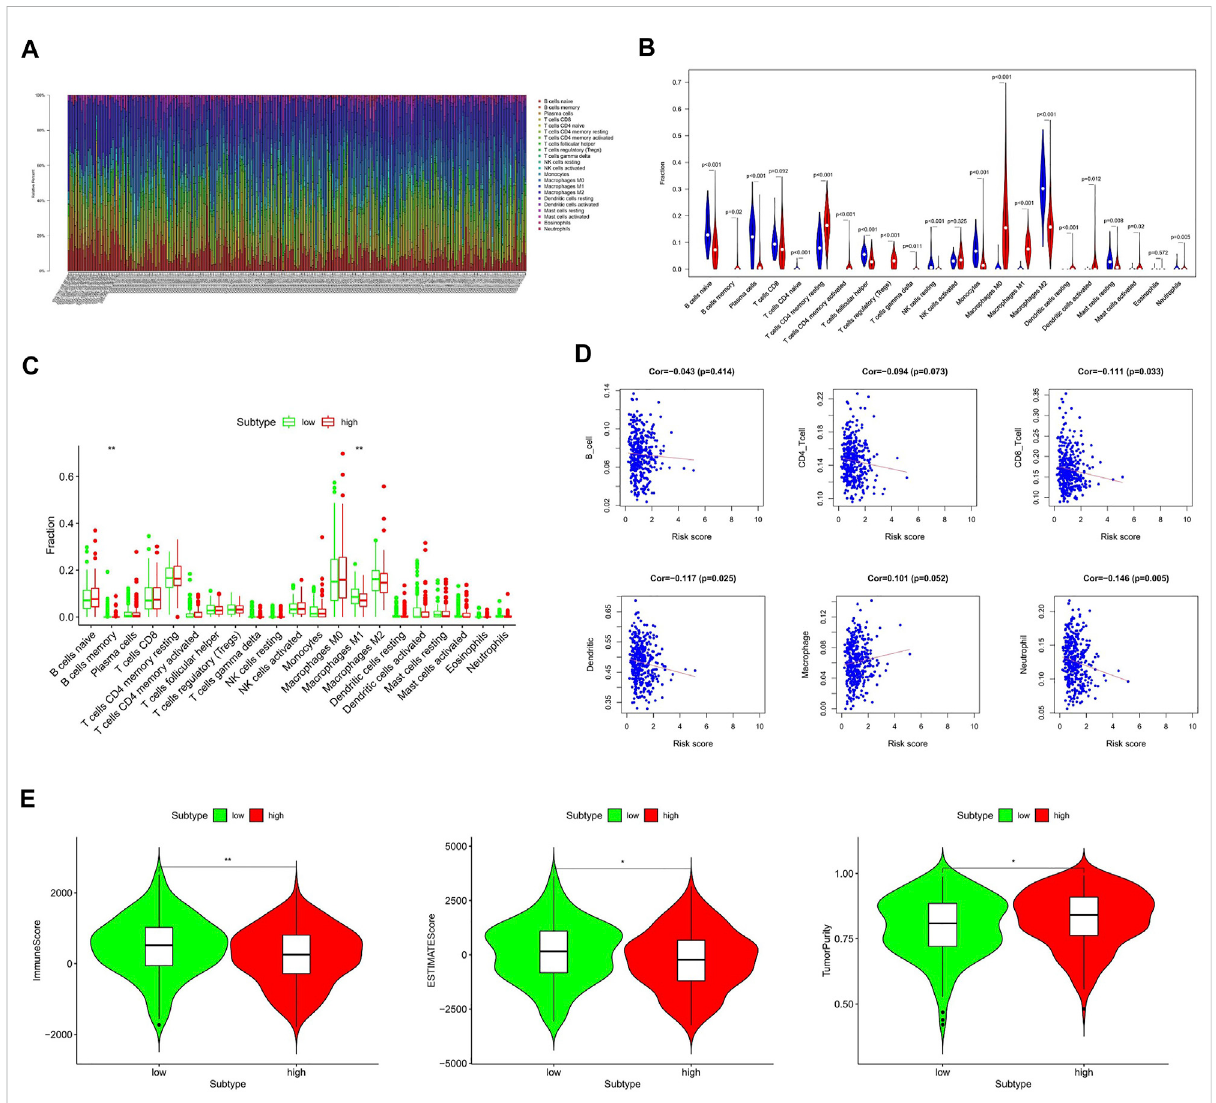
FIGURE 5 Relationship between the HAM signature and immune in fi ltration. (A,B) Prediction of immune cell proportion in TCGA and GTEx samples. (C) Comparison ofrelativeimmunecellabundanceinhigh-riskandlow-riskgroups. (D) Correlationofriskscoreandimmunein fi ltrates. (E) Comparison of tumor immune score in high-risk and low-risk groups based on the ESTIMATE R package. *Statistically signi fi cant p < 0.05; **: statistically signi fi cant p <